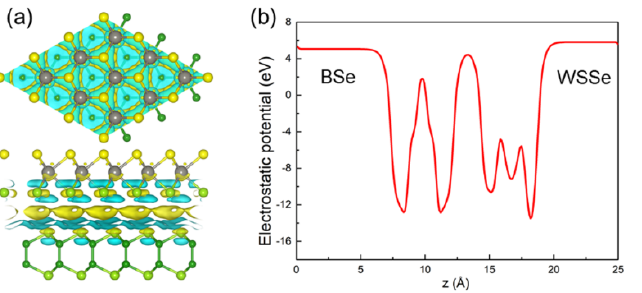
Figure 6. ( a ) The charge density and the ( b ) potential drop of the WSSe/BSe vdW heterostructure; the cyan and yellow regions indicate the loss and gain of the electron, respectively; the isosurface of charge difference was set to 10 − 4 | e |.